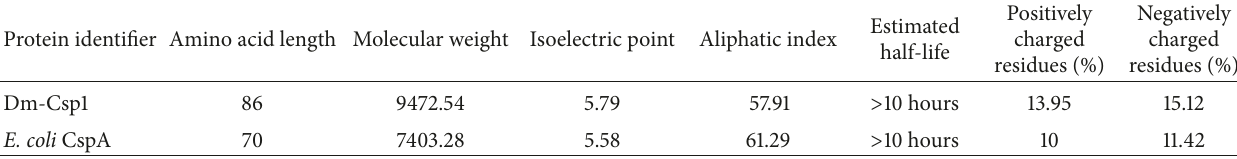
Table 2: Physiological and chemical properties of Dm-Csp1 and E. coli K12 CspA a